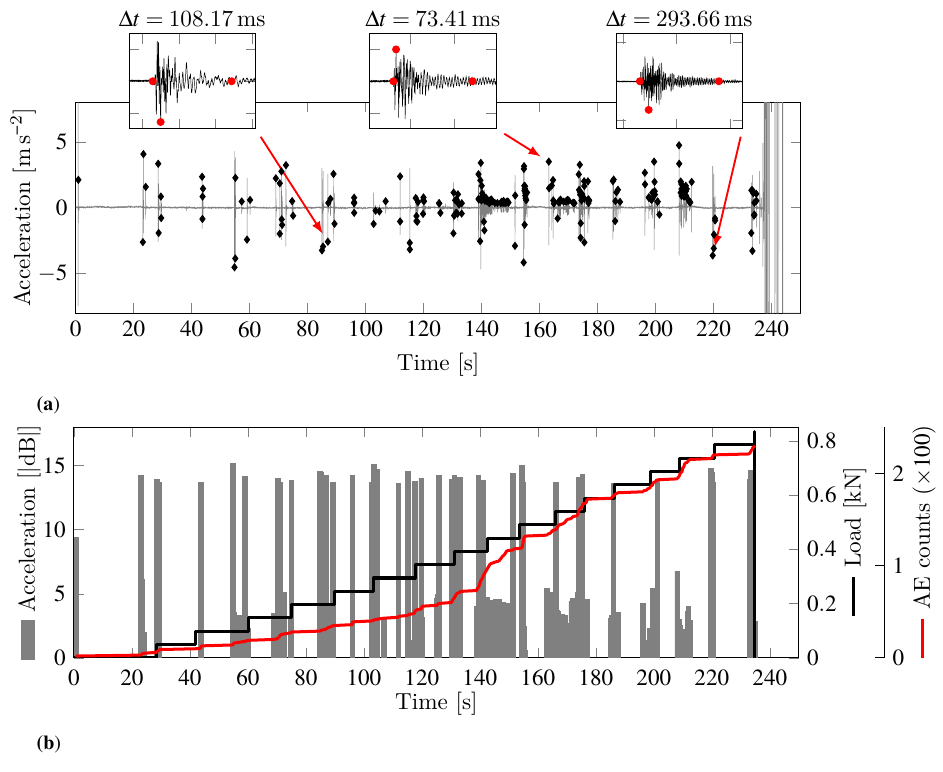
Figure 11. ( a ) Acoustic emission (AE) data acquired during the loading test, with illustrating signals from individual signals. ( b ) Load applied to the bridge with corresponding signal counts.